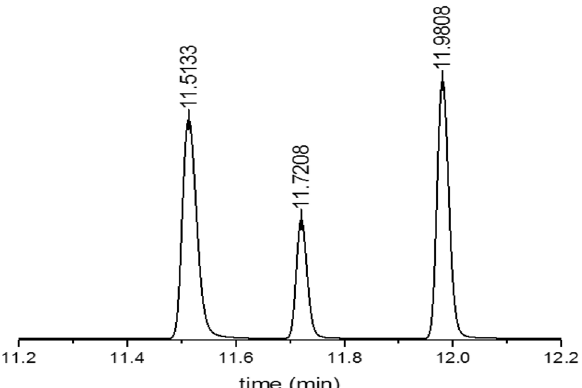
Figure 3. Typical GC spectra (peaks left to right: H 2 , O 2 , N 2 ; units of peak height: pA) measured by an injection at 10 min after decompressing an NBR sample (cylindrical, diameter: 11.5 mm, thickness: 5.3 mm) charged with HP H 2 for 24 h at 9 MPa.